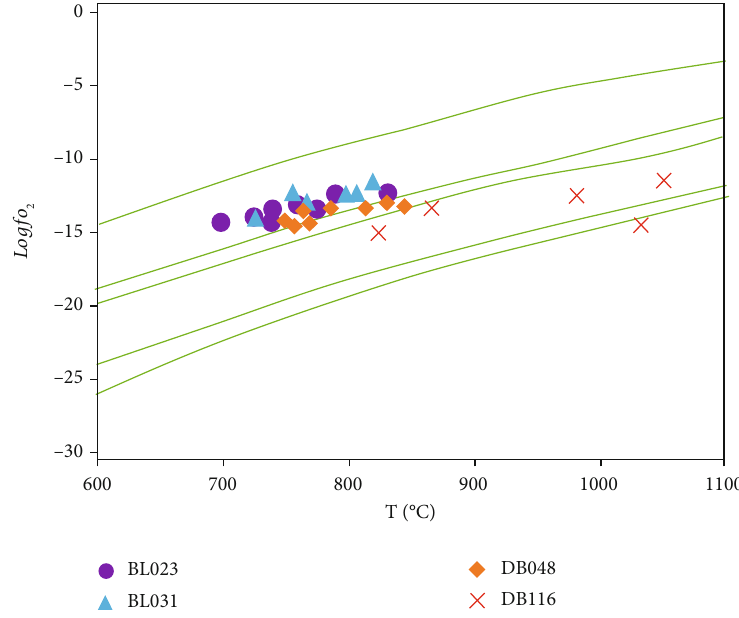
Figure 7: Oxygen fugacity log(fo